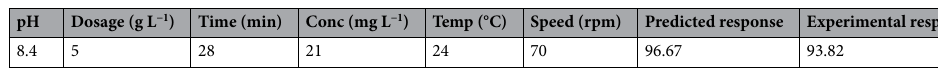
Table 3. The predicted and experimental optimum responses.